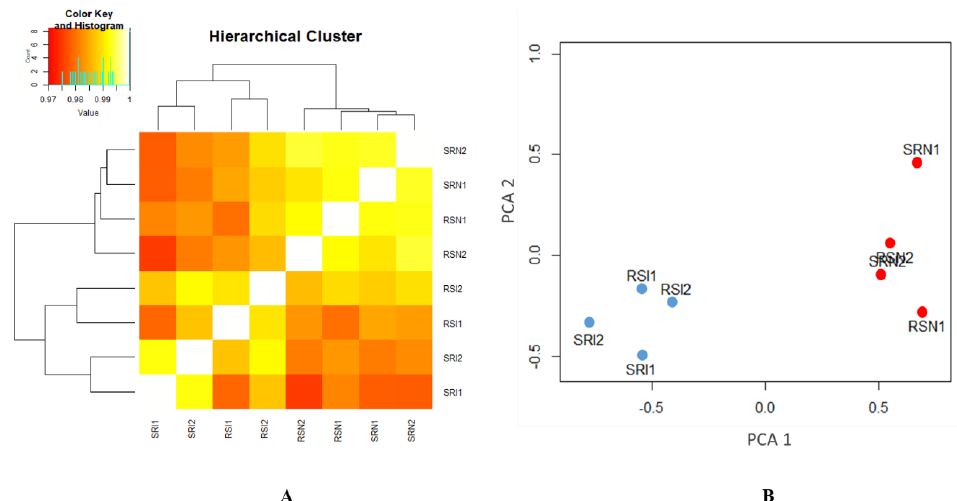
Figure 3. Cluster map of all of the samples. ( A ) Heatmap and hierarchical clustering tree based on the Reynolds’ distance between individuals. RS and SR represent intercrosses 6 3 × 7 2 and 7 2 × 6 3 , respectively. I and N respect infected and non-infected groups, respectively. Two biological replicates are clustered together. ( B ) Principle component analysis (PCA) plots based on the first two principal components. The blue and red dots represent infected and non-infected birds, respectively. The infected and non-infected birds are clustered into two groups.